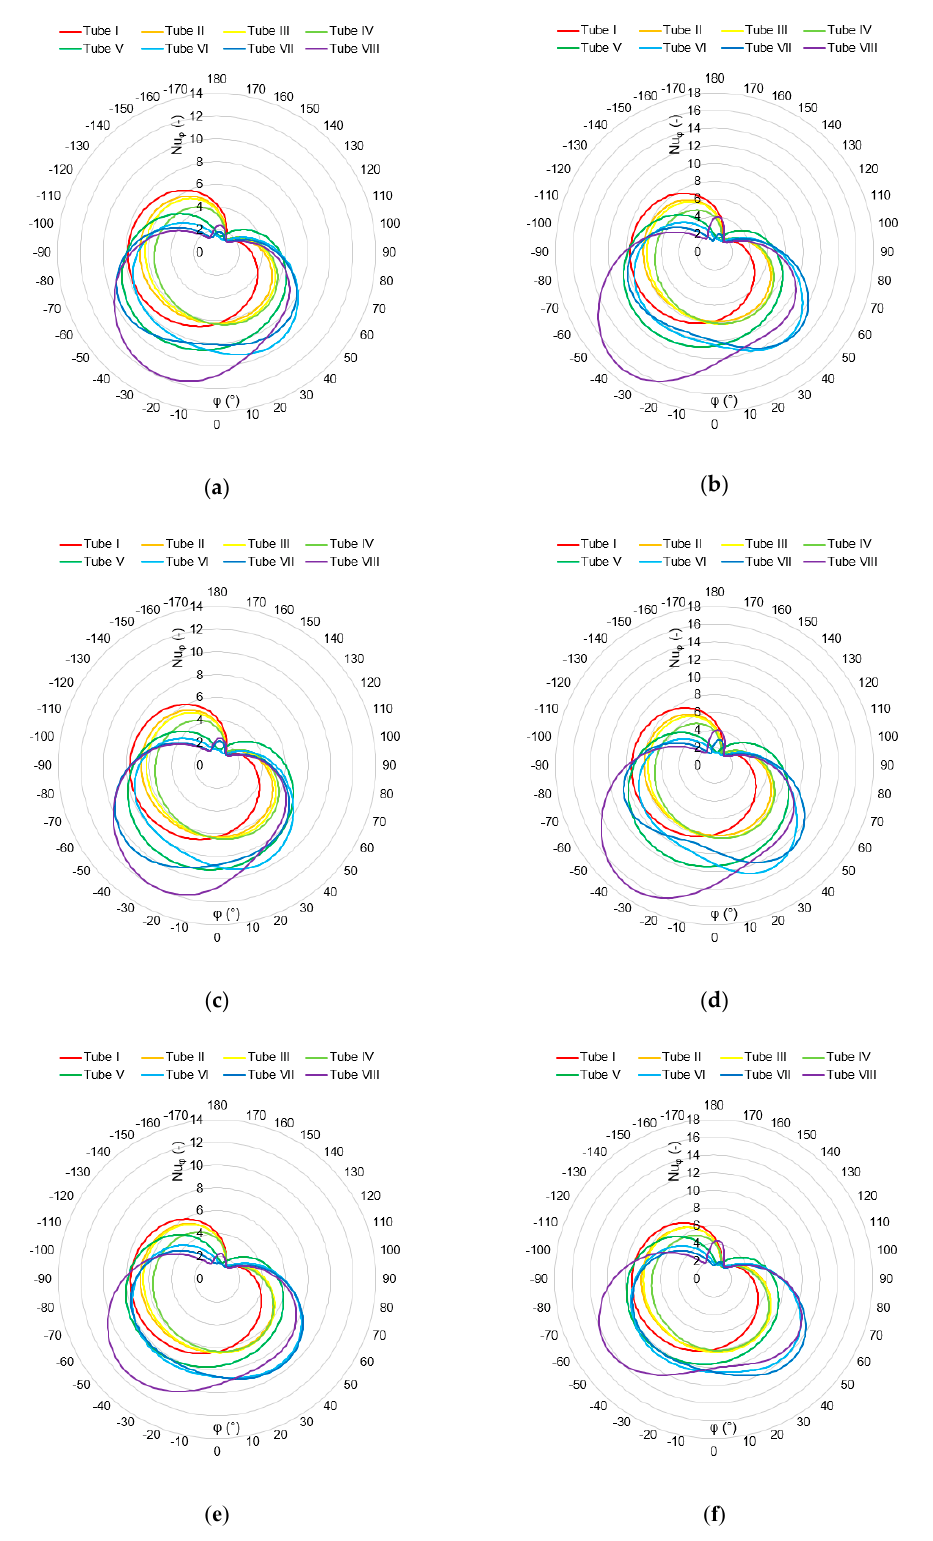
Figure 12. The local Nusselt numbers Nu φ for di ff erent configurations of the tube array 4 × 4 with the tube ratio spacing S / D of 3: ( a ) base configuration at Ra = 1.3 × 10 4 ; ( b ) base configuration at Ra = 3.7 × 10 4 ; ( c ) concave configuration at Ra = 1.3 × 10 4 ; ( d ) concave configuration at Ra = 3.7 × 10 4 ; ( e ) convex configuration at Ra = 1.3 × 10 4 ; ( f ) convex configuration at Ra = 3.7 × 10 4